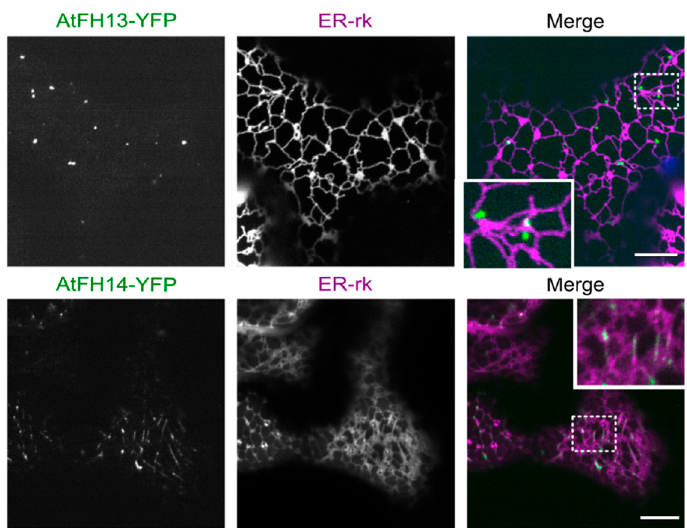
Figure 6. Single optical sections of epidermal cells co-expressing AtFH13-YFP and AtFH14-YFP with the endoplasmic reticulum marker ER-rk. Images from single channels are shown in grayscale, merged images display an overlay of three channels represented by green (YFP), magenta (RFP), and blue (chloroplast autofluorescence). Scale bars are 10 µm, insets are magnified 2.5 times compared to the main image. Construct abbreviations are defined in the text and in Figure 1.